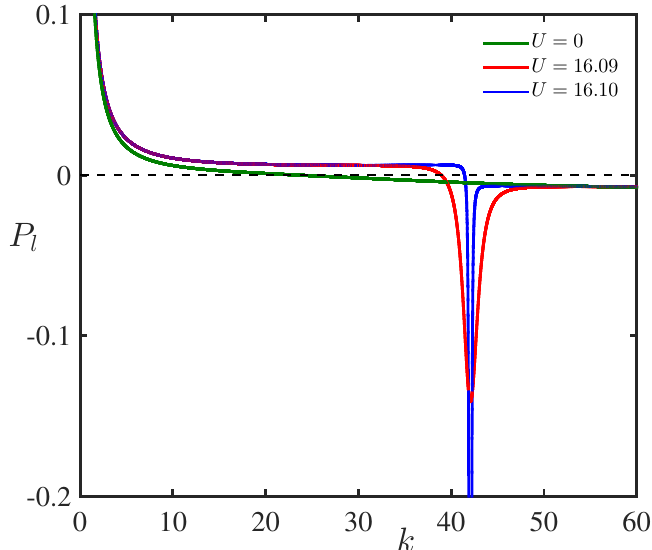
Figure 8. (Color online) Variation of dispersion coefficient P l ( k ) versus wavenumber k for different values of wind speed in the case of the lower branch of the dispersion